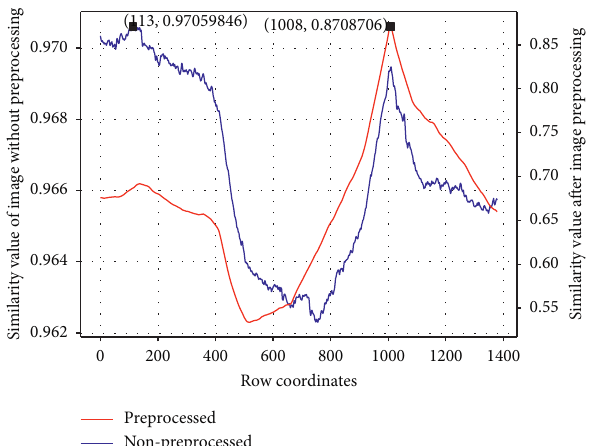
Figure 9: Similarity between the fastener template and each subgraph.